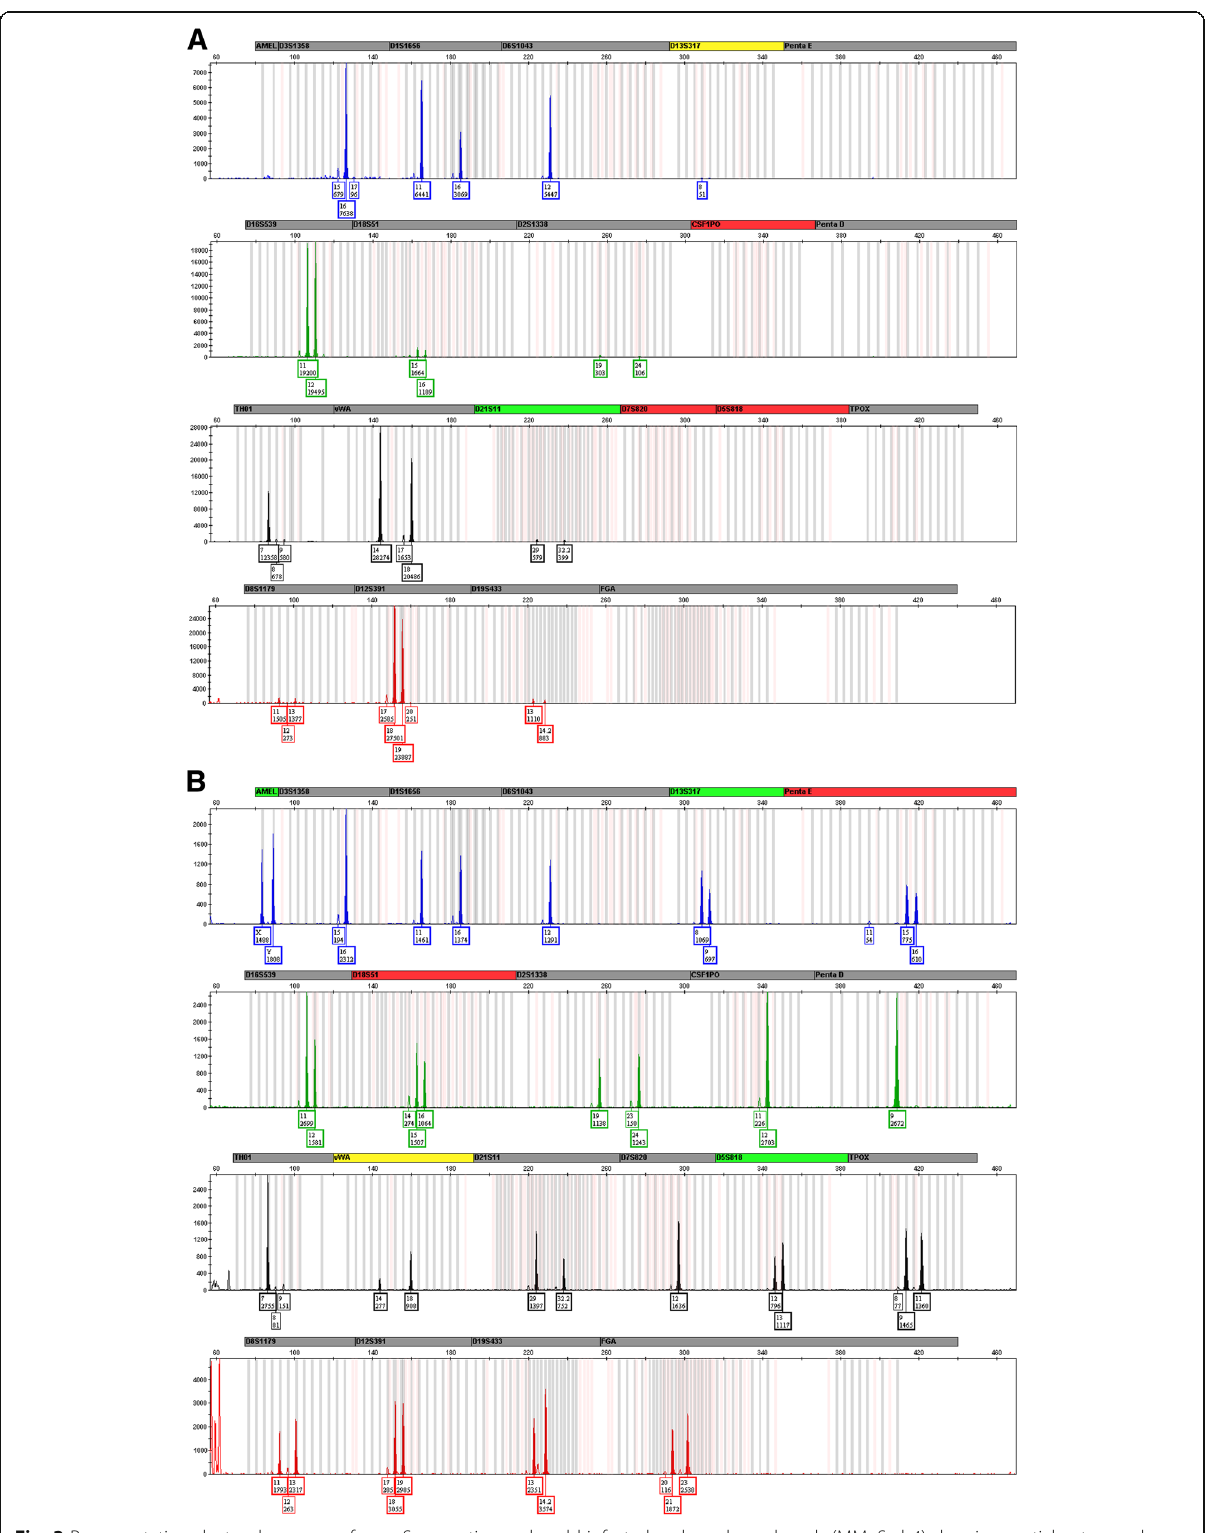
Fig. 3 Representative electropherograms for an Sg-negative and mold-infested male-male anal swab (MM_Swb4) showing partial autosomal allele recovery of the semen contributor after organic extraction ( a ) and full recovery of semen-derived alleles using the silica-based procedure ( b ). Both samples were run in AB® 3500. Semen contributor alleles are